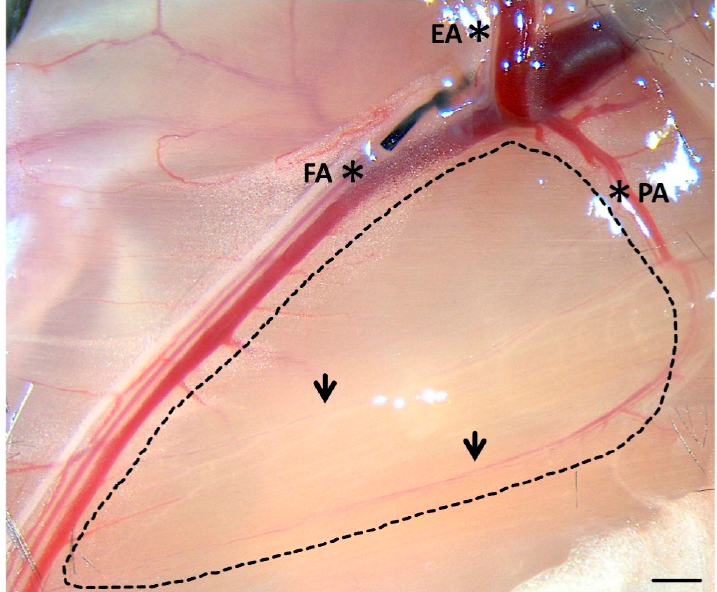
Figure 1. Tissue sampling on the right hindlimb of a C57BL / 6J mouse. The part of the M. adductor containing the collaterals (arrows) was extracted along the dashed line. The collaterals connect the profunda femoris artery (PA) to the femoral artery (FA). The epigastric artery (EA) serves as orientation for the ligation. Scale bar 1mm.